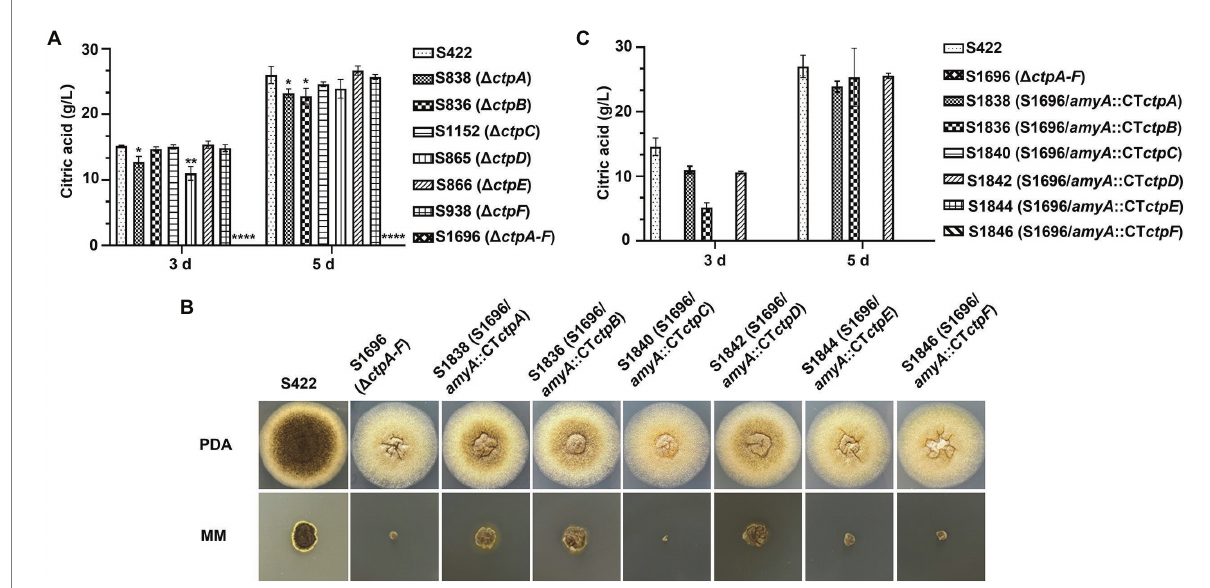
FIGURE 4 Citric acid production and morphology analyses of A. niger strains. (A) In a 250 ml shake flask, 1 × 10 8 conidia of each A. niger strain were inoculated in 50 ml of citric acid fermentation medium at 28 ° C for 3 and 5 days, respectively. Citric acid titers were determined by HPLC. (B) Morphology of A.